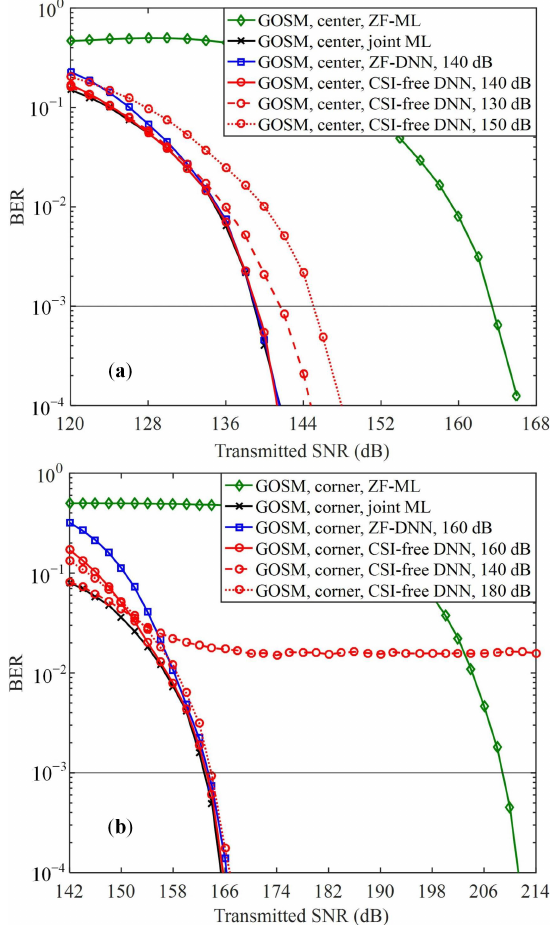
Figure 4. BER comparison of the proposed CSI-free DNN detector and three benchmark detectors for GOSM at ( a ) the center and ( b ) the